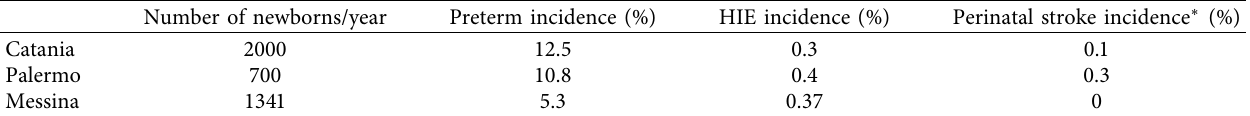
Table 2: The number of births/year and the incidence of cases in our three Sicilian centers. Number of